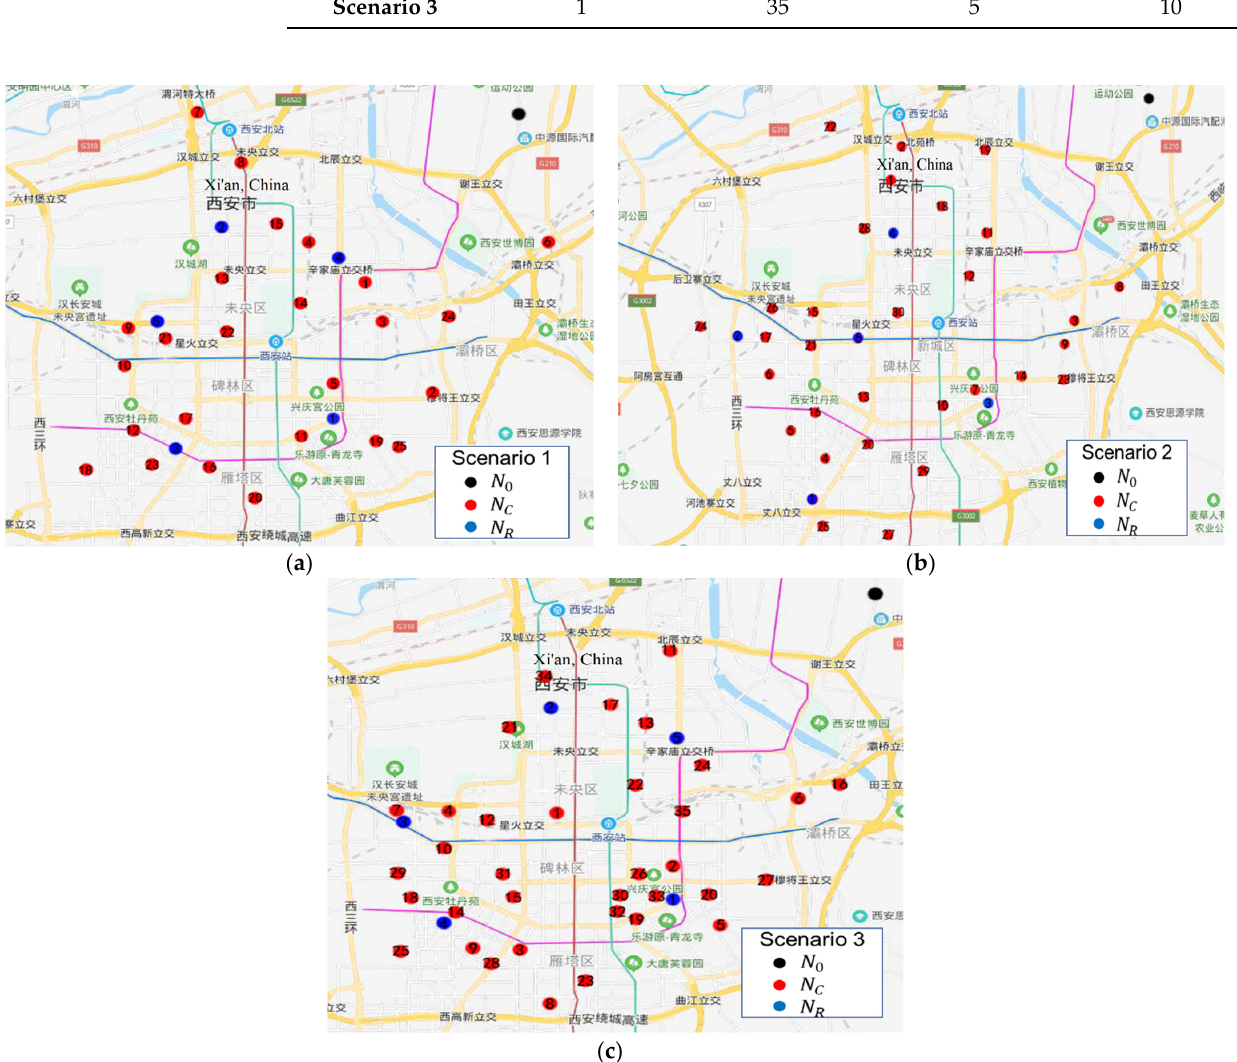
Figure 6. Distribution network in Xi’an, China: ( a ) Scenario 1; ( b ) Scenario 2; ( c ) Scenario